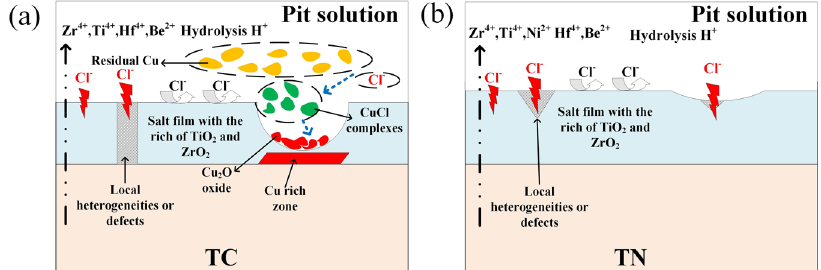
Fig. 12 Schematic diagrams of the pitting mechanisms for different alloys during potentiodynamic polarization in 3.5 wt. % NaCl solution. a TC and b TN.